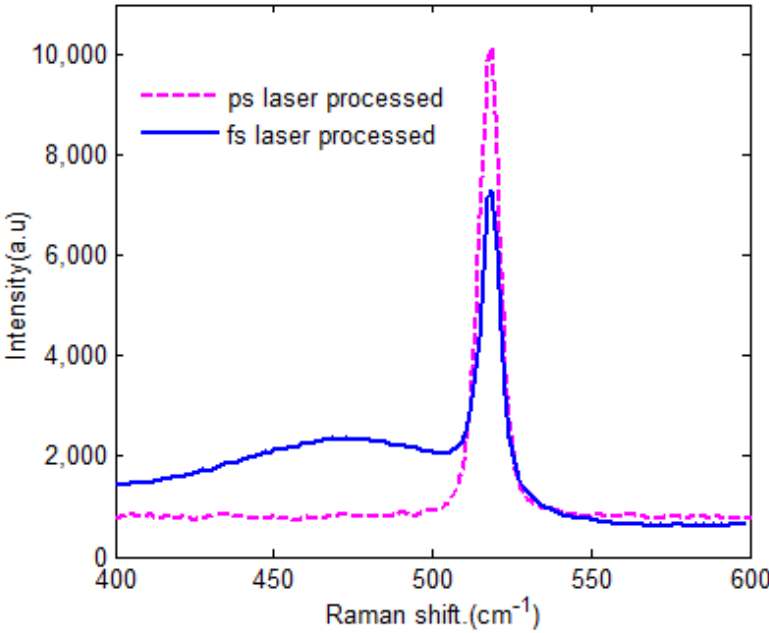
Figure 6. Raman spectra of fs − laser − processed silicon and ps − laser − processed silicon.